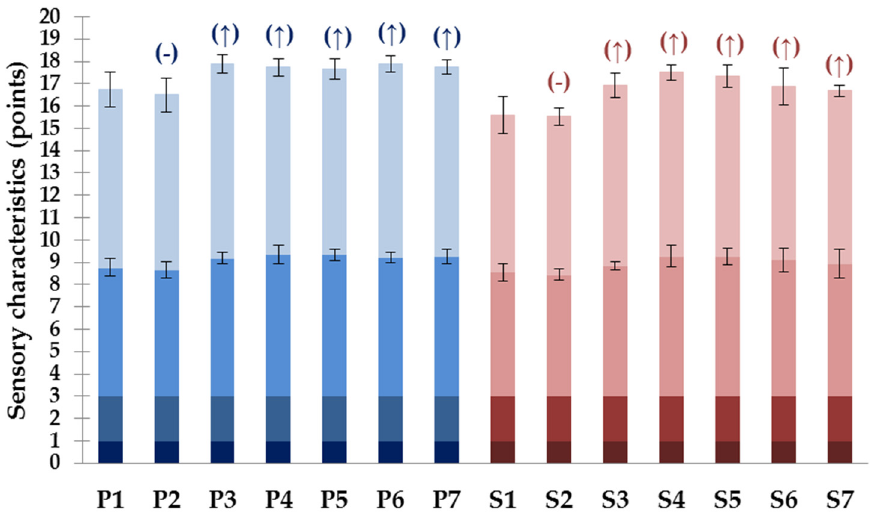
Figure 5. Sensory analysis of plum spirits of Požegaˇca (P) and Stanley (S) varieties produced by traditional process (P1 and S1) and modified process (P2–P7 and S2–S7). Four rectangles from the darkest to the lightest shades of blue (Požegaˇca) and red (Stanley) represent the clearness, colour, odour, and taste of plum spirits. For each plum variety, different marks indicate differences in the means of total sensory quality ( p < 0.05), according to Dunnett test: ( ↑ ) Statistically significant higher values compared to values in traditionally produced plum spirit, ( ↓ ): Statistically significant lower values compared to values in traditionally produced plum spirit, (-): No statistically significant differences in values compared to values in traditionally produced plum spirit. Values of all sensory characteristics are shown as mean ± standard deviation.